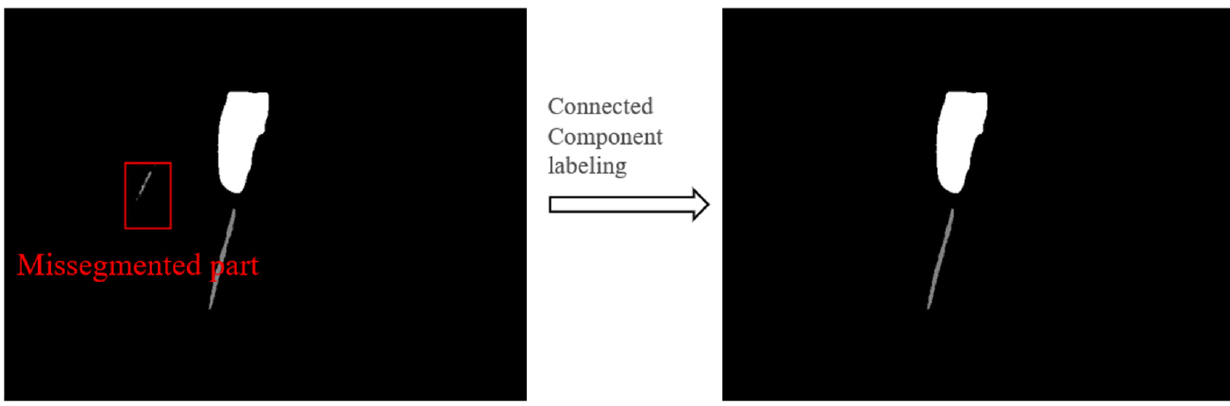
Figure 6. Connected component analysis for mis-segmentation.